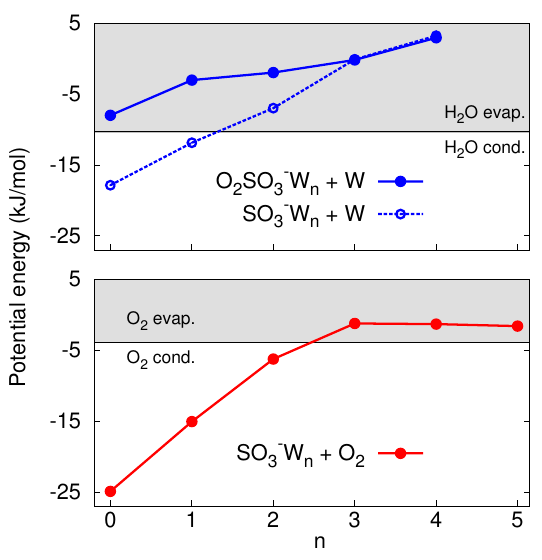
Fig. 9. Gibbs free energies of growth of the clusters via H 2 O and O 2 condensation. “W” is shorthand for water. The regimes of evap- oration and condensation under standard conditions and 50% rel- ative humidity are illustrated, determined using Eq. (13). Assum- ing thermal equilibrium, the final products are mainly O 2 SO − ( H 2 O ) 1 . O 2 SO − 3